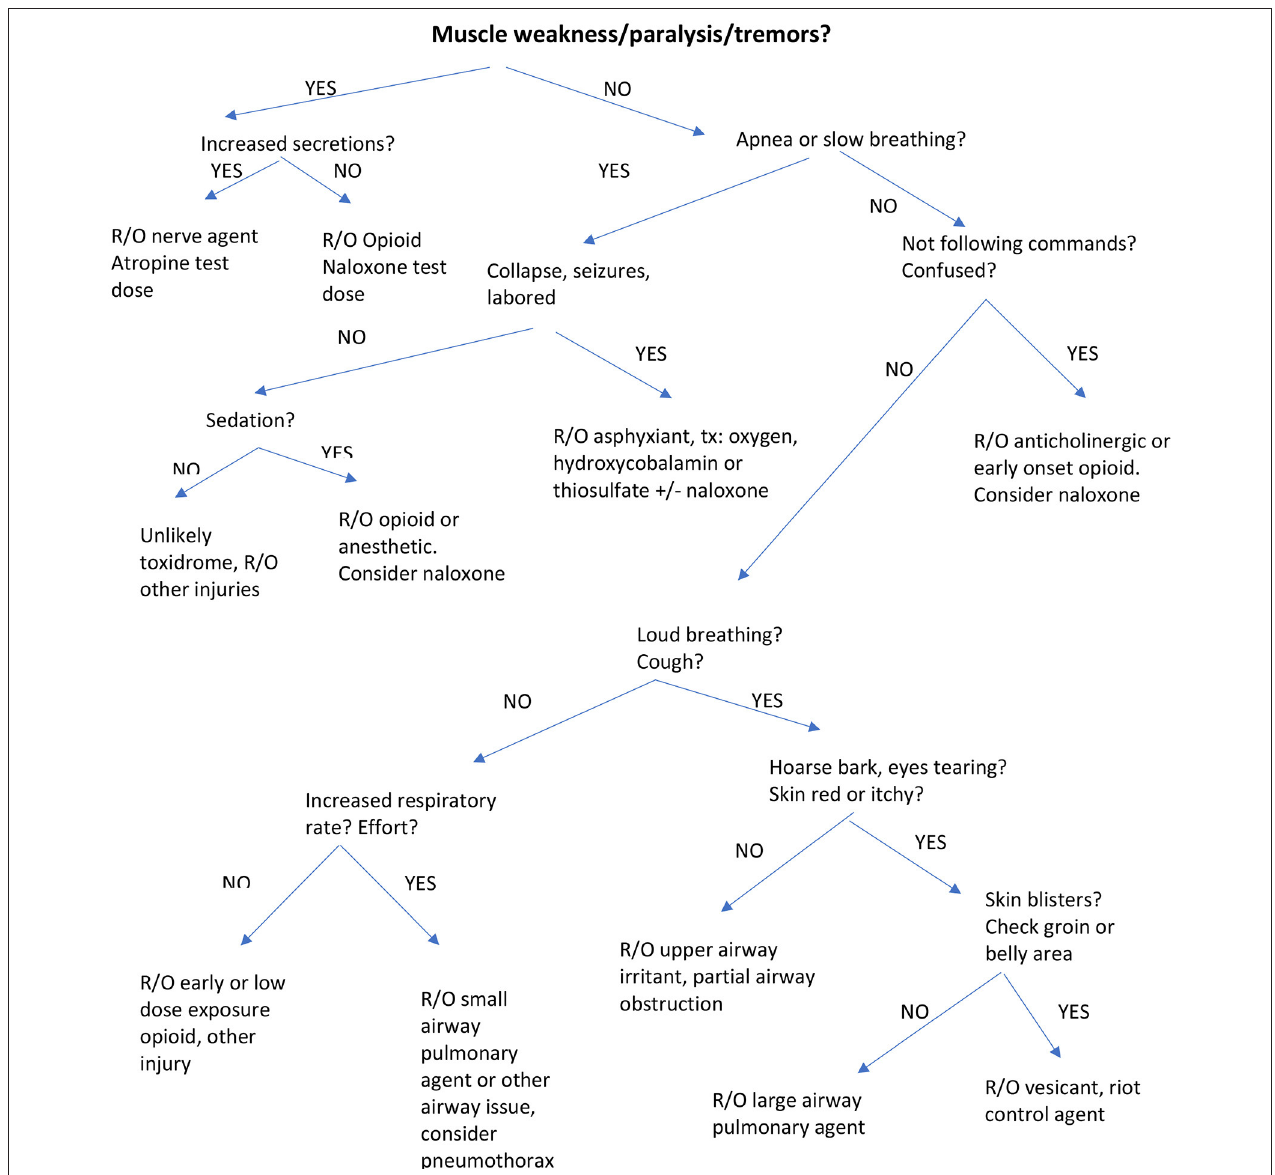
FIGURE 1 | Algorithm for identification of Toxidromes muscle weakness/paralysis/tremors or increased secretions?